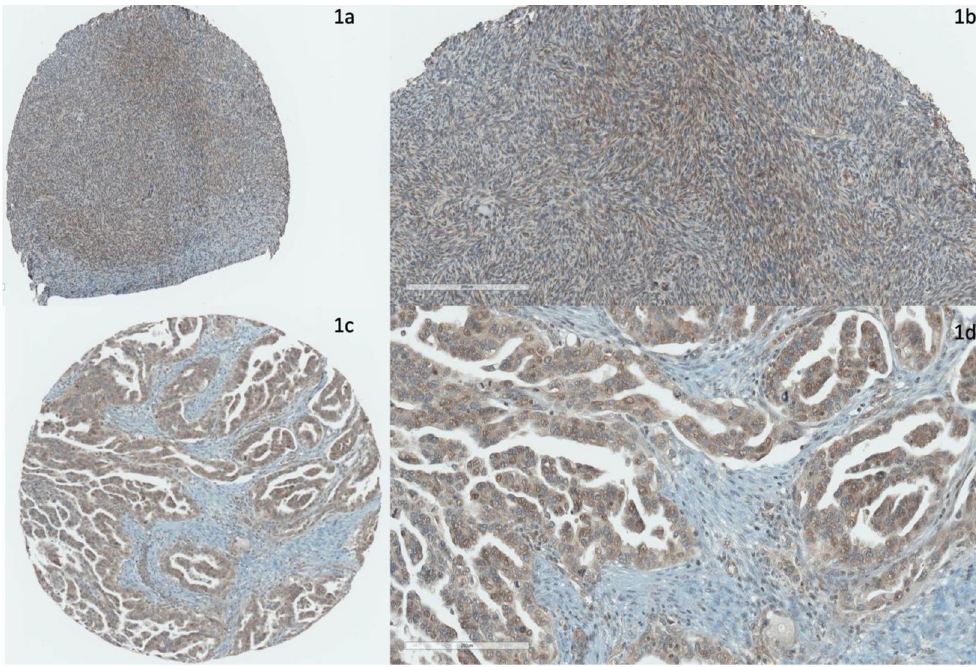
Fig 1. Immunohistochemical expression of Cav-1 in ovarian tissue. (a-b) Normal (benign) ovarian stroma stained with Cav-1 via immunohistochemistry. The fibroblasts in the benign ovarian stroma stain strongly positive for Cav-1. (c-d) High- grade ovarian serous adenocarcinoma stained with Cav-1 via immunohistochemistry. The tumor epithelial cells stain strongly positive for Cav-1, while the fibroblasts in the surrounding desmoplastic stroma stain weakly positive to negative for Cav-1.